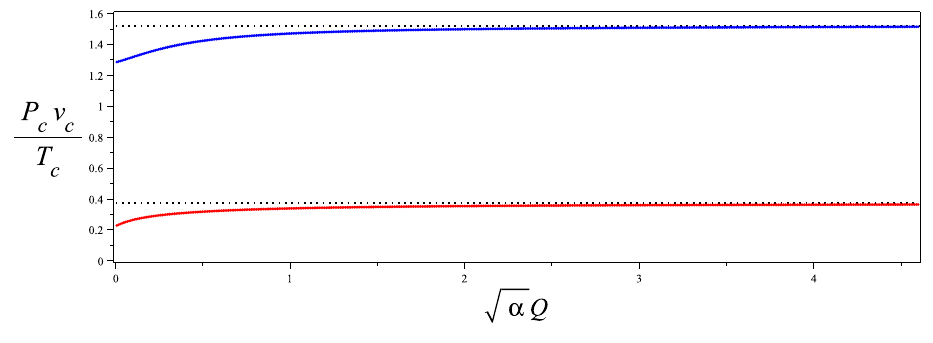
JHEP11(2019)043 p (cid:11)Q (cid:29) 1, while the hairy critical